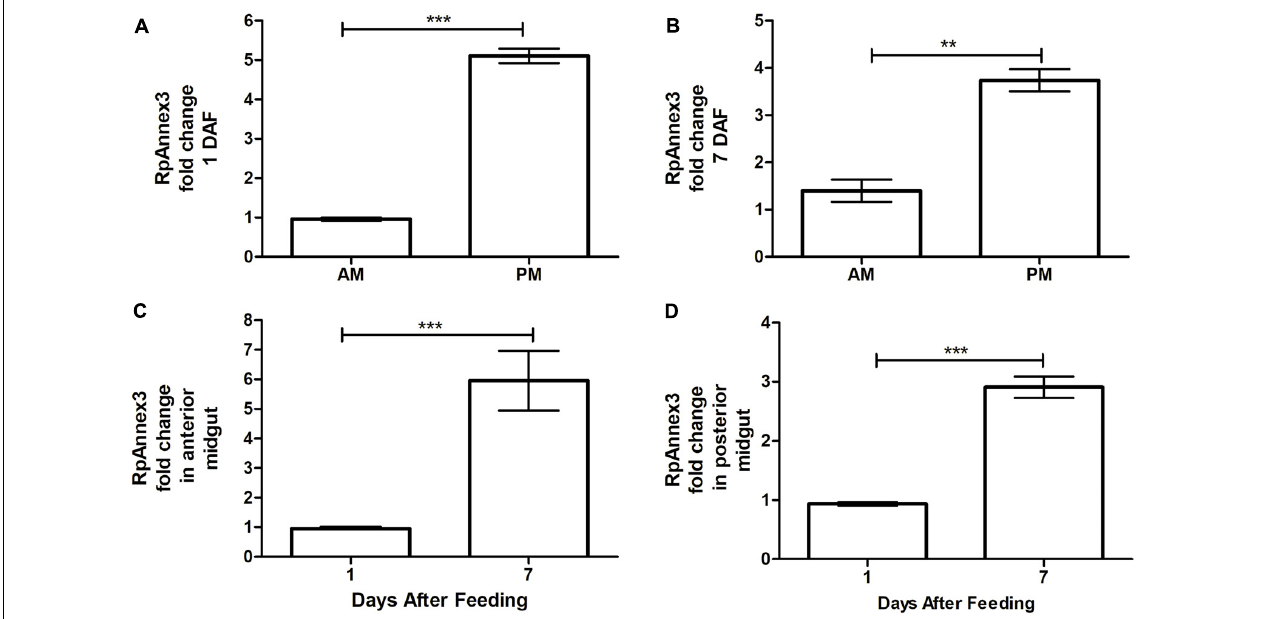
FIGURE 8 | Spatial and temporal relative gene expression of RPRC013832 (RpAnnex3) in fifth instar nymphs of Rhodnius prolixus . Blood-fed insects were dissected and tissues were separated in anterior midgut (AM) and posterior midgut (PM) at 1 and 7 days after feeding. (A) Expression of RpAnnex3 in AM and PM at 1 day after blood feeding, (B) Expression of RpAnnex3 in AM and PM at 7 day after blood feeding, (C) Expression of RpAnnex3 in AM at 1 and 7 days after blood feeding, (D) Expression of RpAnnex3 in PM at 1 and 7 days after blood feeding. Calibrators genes used in the relative quantification of gene expression were α -tubulin and GAPDH . Bars represent the mean ± the standard error of the mean (SEM) of two independent experiments with three pools of R. prolixus ( n = 3). Means were compared applying Student’s t -test; ** p < 0.01 and *** p <